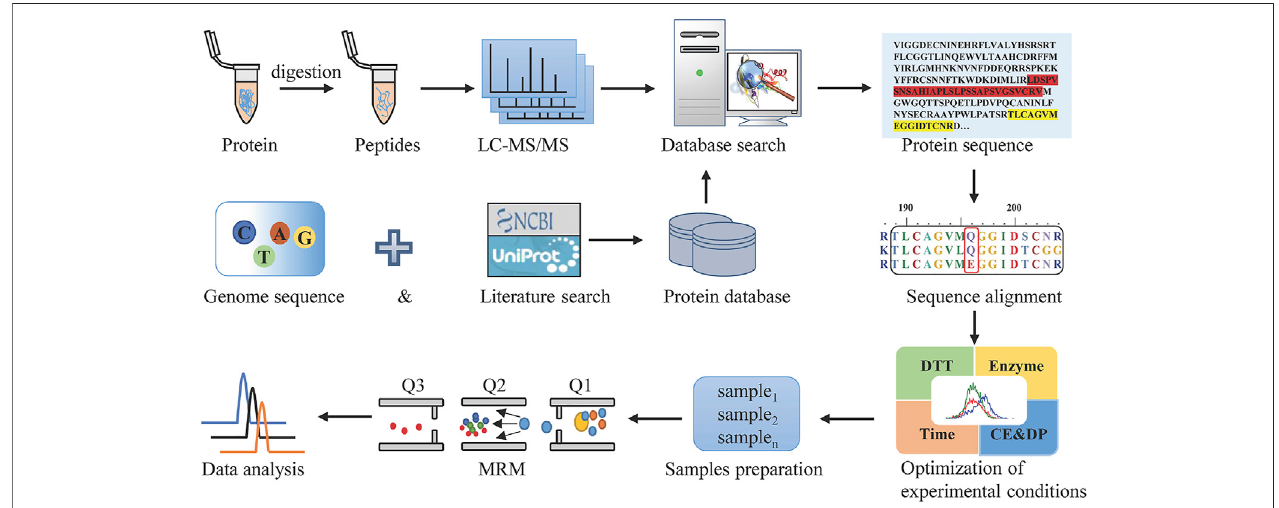
FIGURE 1 | Work fl ow to discover the marker peptides for analyzing Hemocoagulase Agkistrodon halys pallas